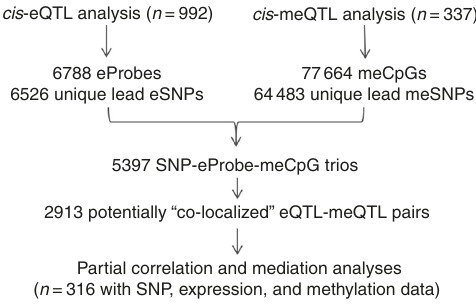
Fig. 1 Summary of the work fl ow for cis -QTL, co-localization, partial